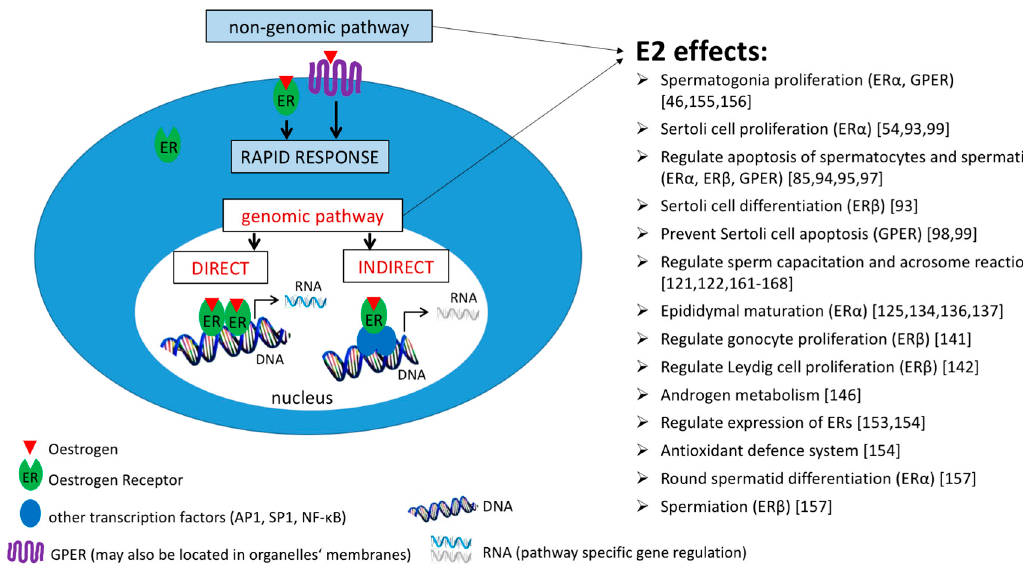
Figure 1. Oestrogen signalling pathways. Genomic pathway (white boxes): E2–ER binding leads to the activation of the relevant receptors, formation of homo- or hetero-dimers, binding to ERE (oestrogen response element) in the promotor sequence of a target gene and regulation of its transcription. Alternatively, E2-ER can bind to other transcription factors such as AP-1, Sp-1 or NF- κ B, through which they indirectly regulate the expression of the target gene. Non-genomic pathway (blue boxes): E2 binds to receptors localised in the membrane (GPER) or its proximity (ER α , ER β ), which results in rapid cellular responses such as activation of protein kinases, regulation of ion channels or production of second messengers. Both pathways play an important role in oestrogen-mediated events in the testis, and the non-genomic one also in sperm; the known E2 effects are listed on the right-hand side of the diagram.